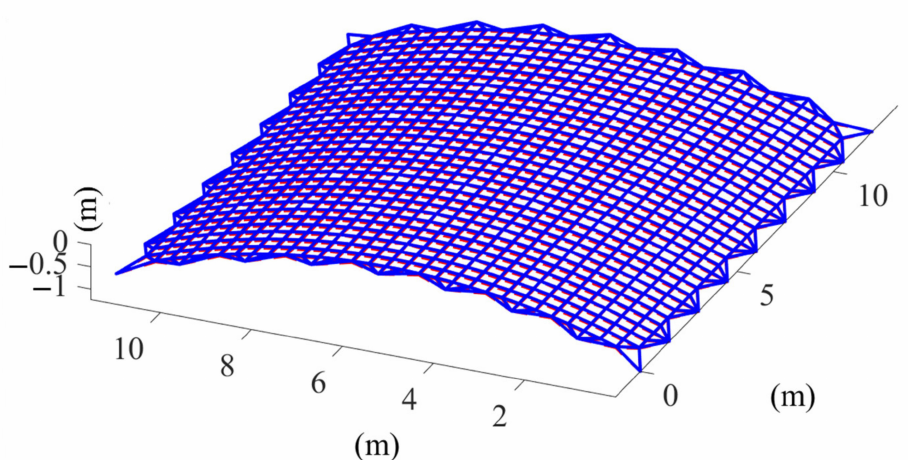
Figure 11. Difference value of the RMS between adjacent algebras.